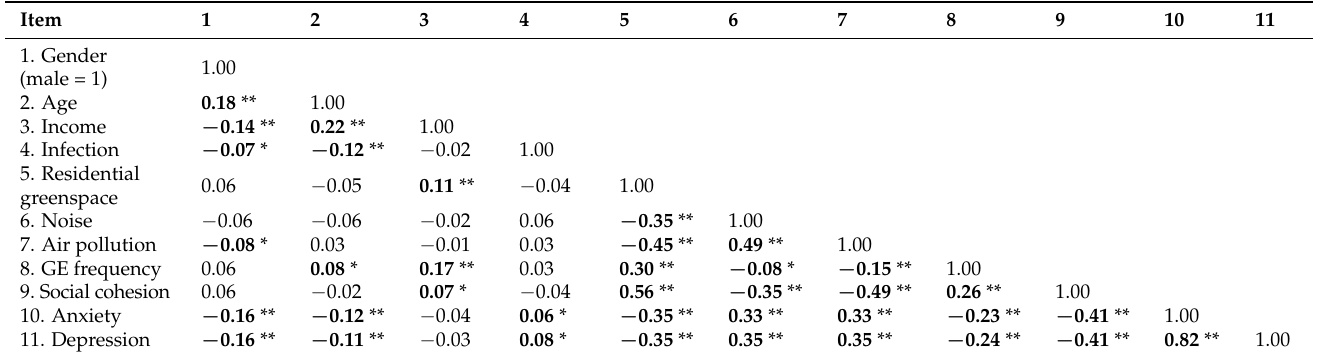
Table 2. Bivariate Spearman or point-biserial correlations ( n = 967).